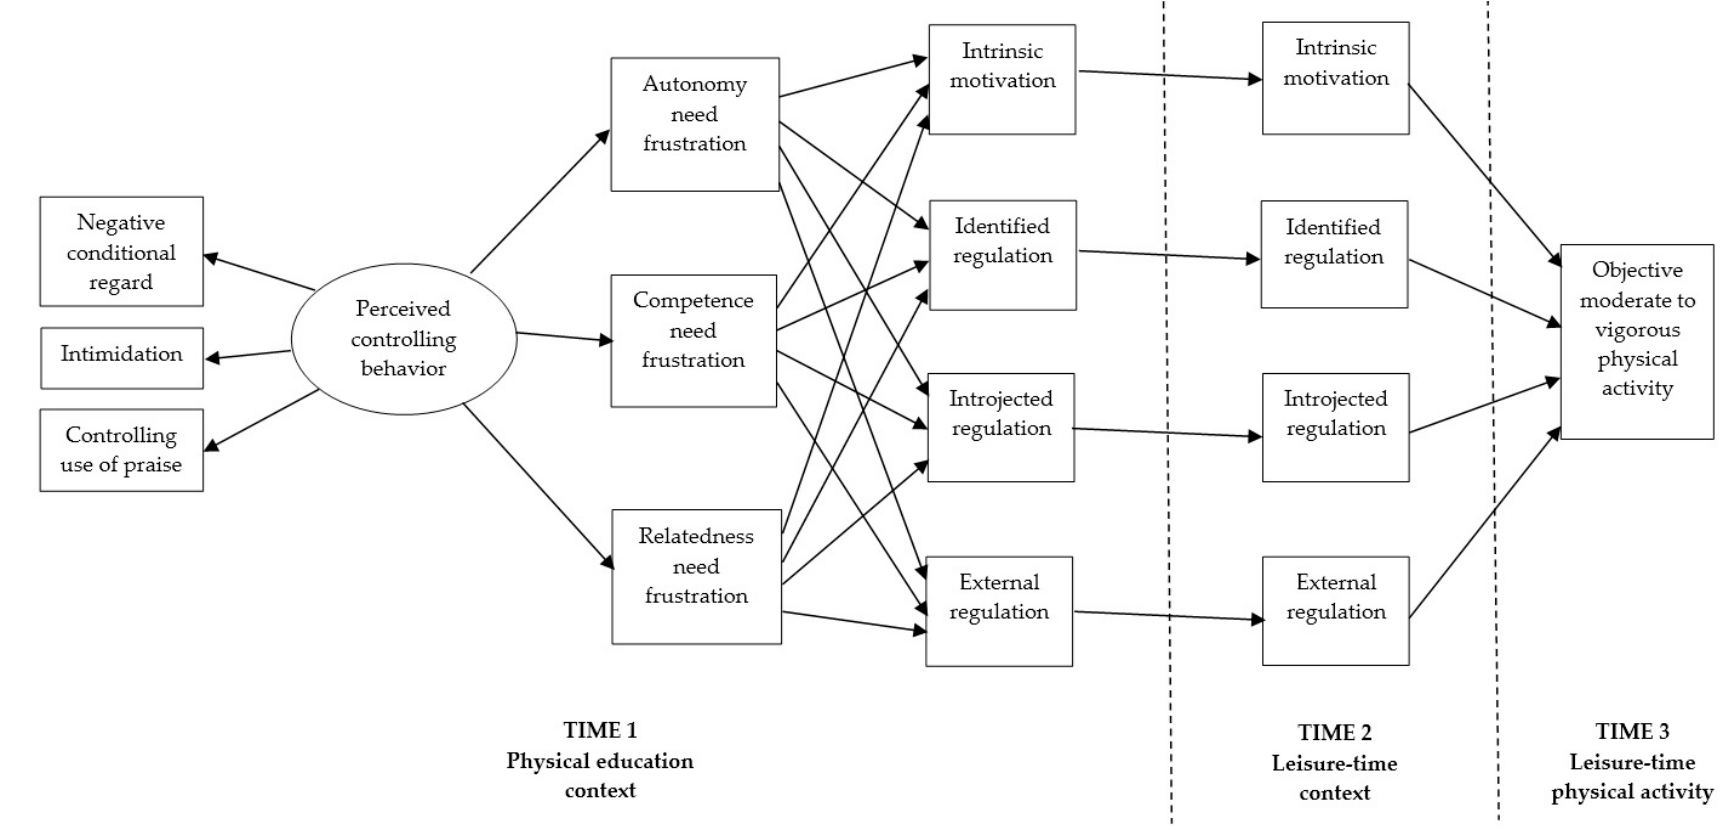
Figure 1. The hypothesized model. For clarity, the paths from past physical activity behavior to endogenous variables and error covariances among need frustration variables as well as different motivational regulation variables in physical education and leisure-time contexts are not depicted.